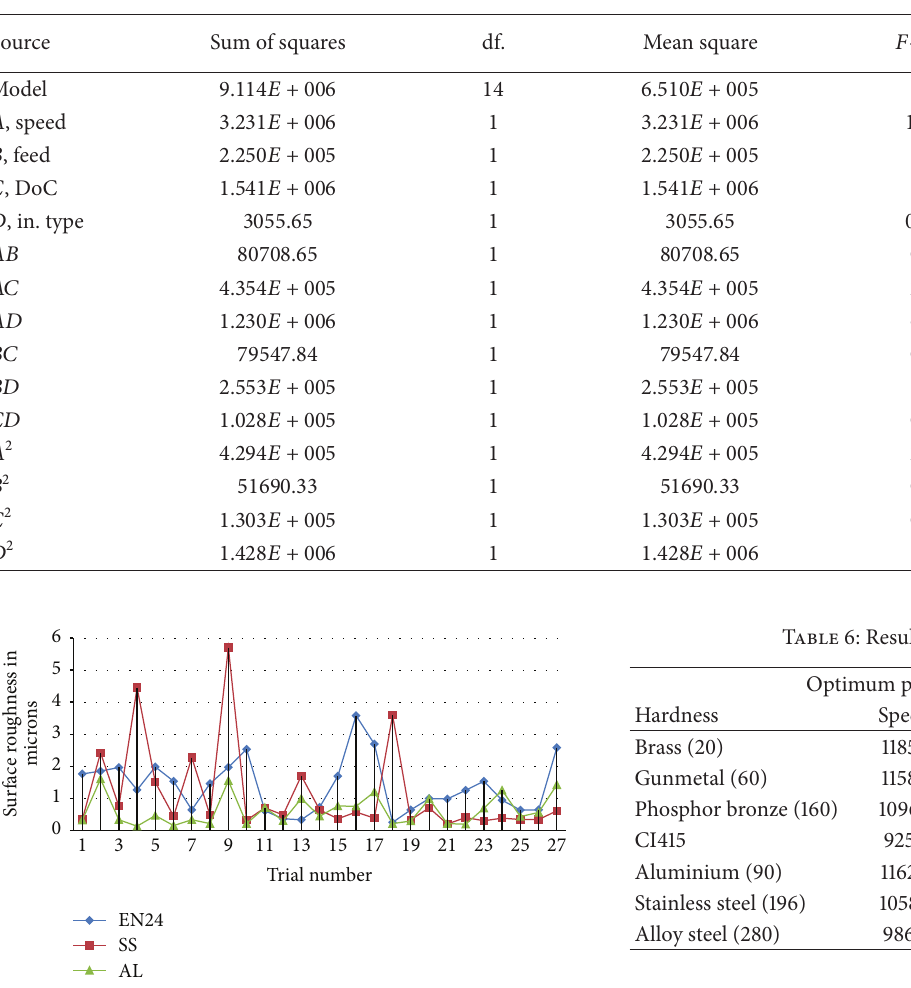
Figure 1: Surface roughness variations of ductile materials in microns.